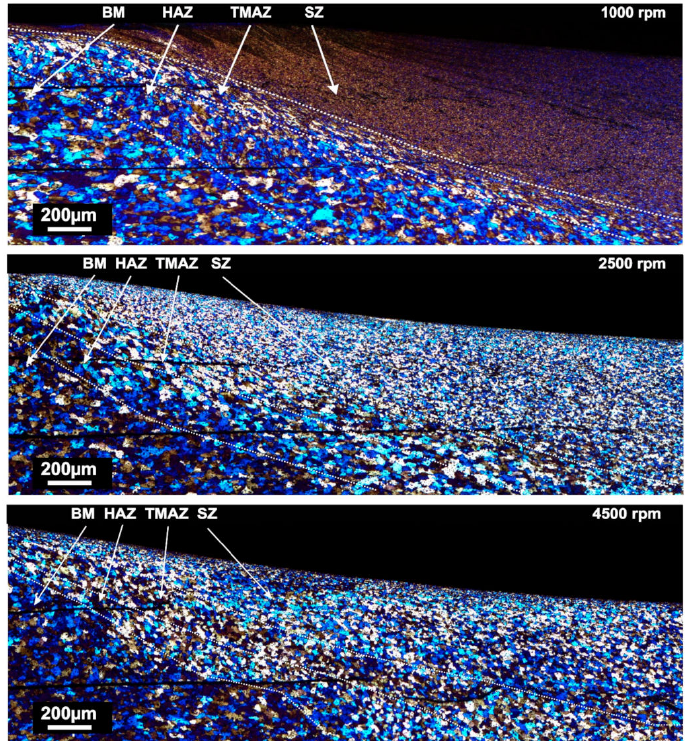
Figure 10. Micrographs showing the transition between the base material and stir zone for samples welded with 1000, 2500 and 4500 RPM from the batch I (BM–Base material; HAZ–Heat affected zone; TAMAZ–Thermo-mechanically affected zone; SZ–Stir